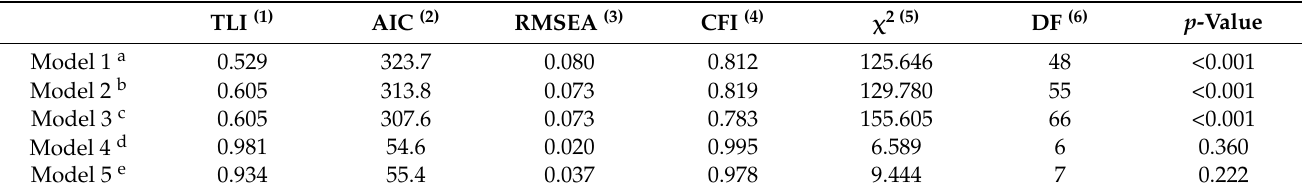
Table 6. Overview of the path analysis.